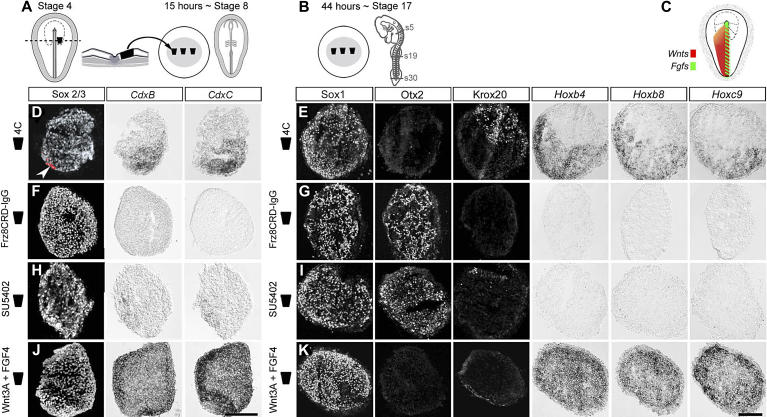
Cells of Spinal Cord Character Are Induced by Combinatorial Wnt and FGF Signaling at the Late Gastrula Stage(A and B) Caudal (C) neural plate tissue explants (black box) were isolated from HH stage 4 embryos and embedded in collagen matrix where their rostrocaudal orientation was maintained during in vitro cultivation for 15 h, corresponding to a stage 8 embryo (A, D, F, H, and J) or for 44 h, corresponding to a stage 17 ˜30-somite embryo (B, E, G, I, and K).(C) Schematic drawing indicating the expression pattern of
Wnt (red) and
Fgf genes (green) in the primitive streak and caudal ectoderm, and in the node and primitive streak, respectively. Black dotted line indicates the presumptive neural plate.
(D–K) Each row represents consecutive sections from a single explant.(D, F, H, and J) Sox2/3 was used as a presumptive neural marker.(D) Stage 4 C explants were DiI-labeled and cultured alone. Cells in the caudal domain of the explants, close to the DiI-labeled cells, expressed
CdxB and
CdxC (
n = 12 explants). White arrowhead indicates the DiI-labeled cells.
(E, G, I, and K) Sox1 was used as a general neural marker.(E) Cells in the rostral domain of 4 C explants cultured alone expressed Krox20, whereas
Hoxb4
+/b8
+/c9
+ cells appeared in the caudal domain of the explants. A small domain of
Hoxb4
+/b8
+/

c9
− cells, but no domain of cells expressing
Hoxb4 alone, were generated (
n = 30 explants).
(F) Explants cultured in the presence of mFrz8CRD-IgG conditioned medium (300 μl/ml culture medium) generated Sox2/3
+ neural cells but no
CdxB or
CdxC positive caudal neural cells (
n = 11 explants).
(G) Explants cultured in the presence of mFrz8CRD-IgG conditioned medium (300 μl/ml culture medium) generated Otx2
+ but no, or few, caudal neural cells (
n = 12 explants).
(H) Explants cultured in the presence of SU5402 (5 μM), an inhibitor of FGF signaling, generated Sox2/3
+ neural cells but no
CdxB or
CdxC positive caudal neural cells (
n = 8 explants).
(I) Explants cultured in the presence of SU5402 (5 μM), an inhibitor of FGF signaling, generated Otx2
+ but no, or few, caudal neural cells (
n = 9 explants).
(J) Simultaneous exposure to Wnt3A (˜75 ng/ml) and FGF4 (60 ng/ml) resulted in the generation of cells that expressed
CdxB and
CdxC in the entire explant (
n = 17 explants). Scale bar represents 100 μm.
(K) Exposure to Wnt3A (˜75 ng/ml) and FGF4 (60 ng/ml), in combination, almost completely blocked the generation of Krox20
+ rHB cells, and only
Hoxb4
+/b8
+/c9
+ spinal cord cells were generated (
n = 17 explants). Scale bar represents 100 μm.